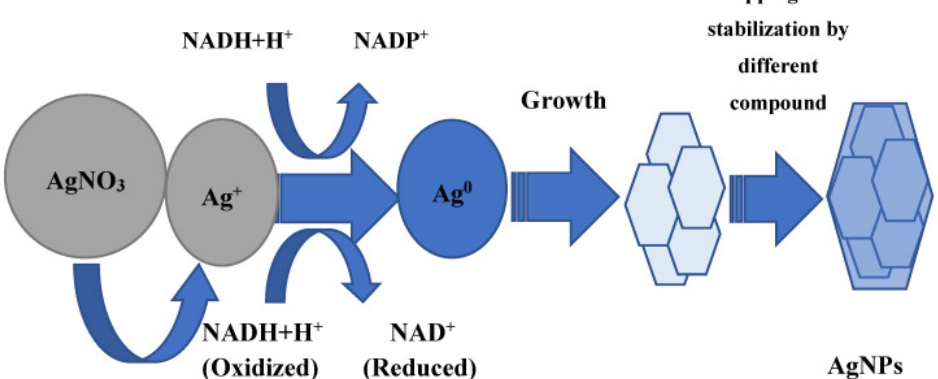
Figure 4. The general hypothetical mechanism proposed for the mycosynthesis of AgNPs (adapted from [55]; an open access